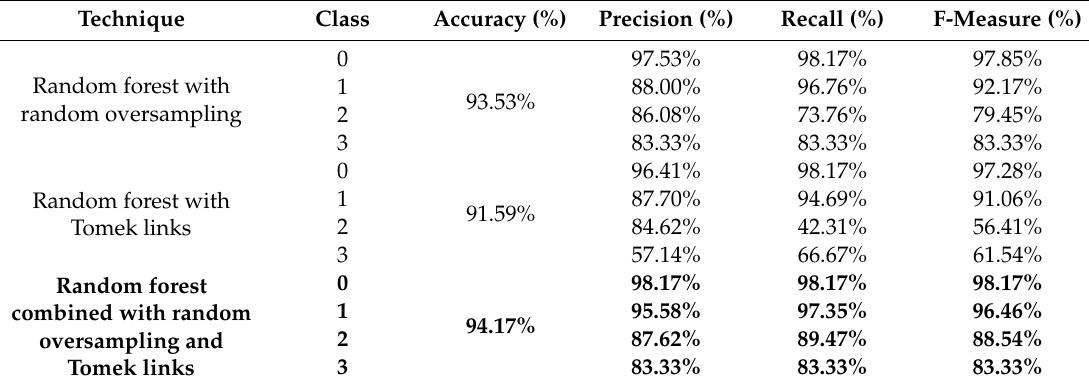
Table 9. Performance of our hybrid sampling compared with random oversampling and Tomek links techniques.